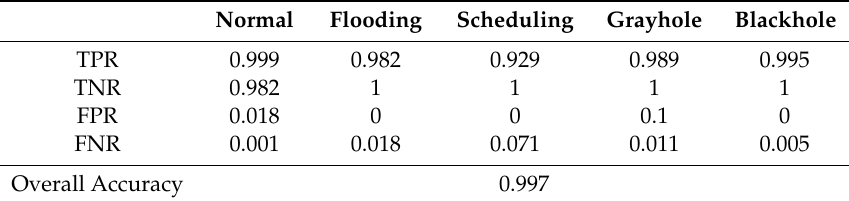
Table 7. Positive and negative rates results of the 10 folds cross validation.